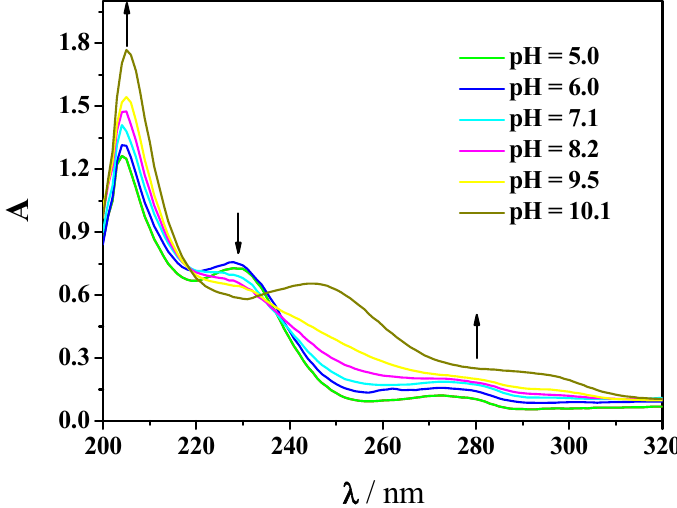
Figure 6. Experimental spectra at different pH on solutions containing Mn 2+ (M) and Amox (L) at C M = 0.05 mmol L − 1 and C L = 0.075 mmol L − 1 , t = 25 °C, I = 0.15 mol L − 1 in NaCl.